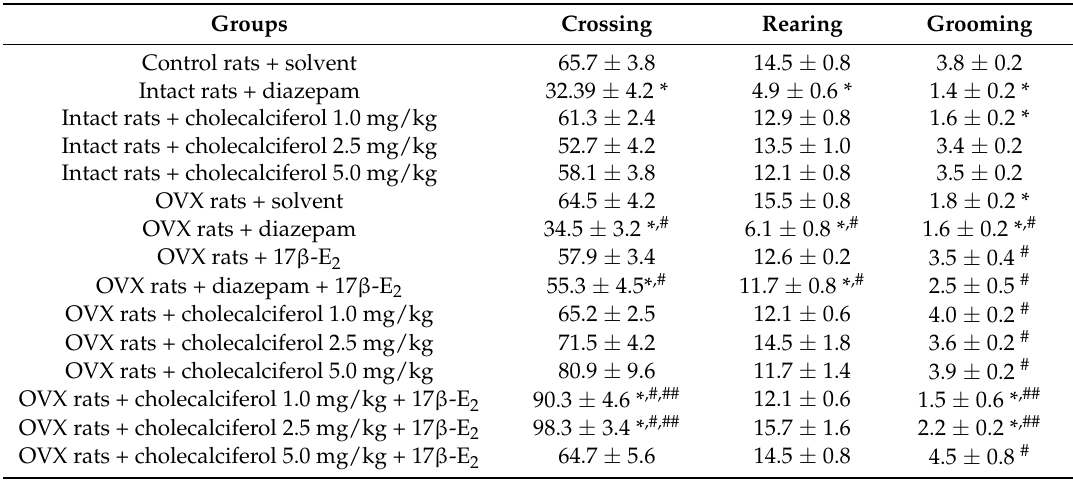
Table 1. Effects of cholecalciferol administration on behavioral impairments of OVX rats following long-term estrogen deficiency in the open field test for 5